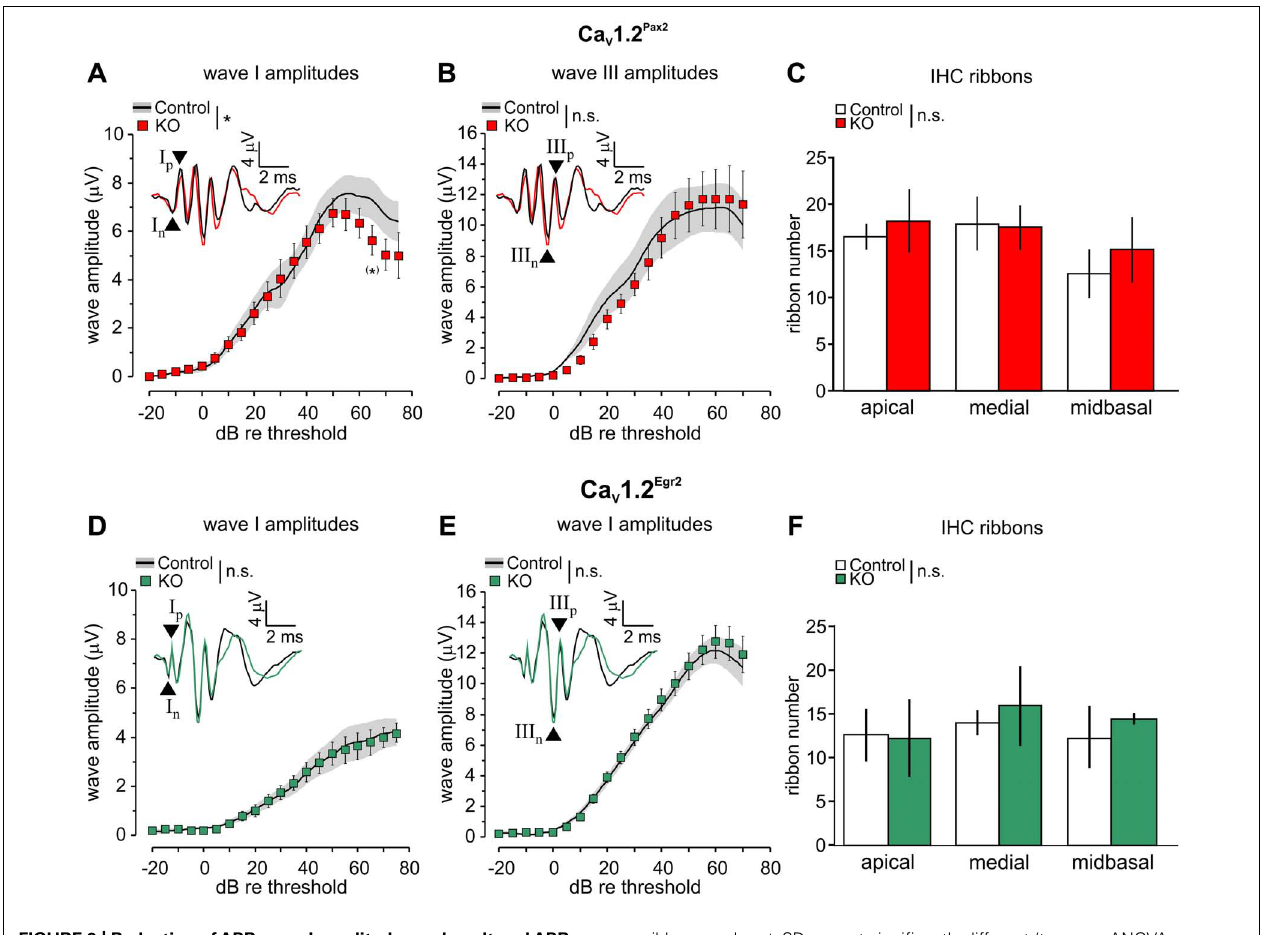
FIGURE 3 | Reduction ofABR wave I amplitudes and unalteredABR wave III amplitudes in Ca V 1.2 Pax2 KO mice. (A) Mean ± SEM click- evoked ABR wave I amplitude growth function for Ca V 1.2 Pax2 control (control, black line, and gray area) and Ca V 1.2 Pax2 KO mice (KO, red squares). ABR wave I amplitudes were significantly different (two-way ANOVA, p = 0.048) between KO ( n = 5–9 ears, 3–6 mice) and controls ( n = 3–6 ears, 3–6 mice), particularly at 65 dB above threshold ( post hoc one-sided Student’s t -test: p = 0.049, no Bonferroni–Holm’s adjustment for multiple testing).The black and red waveforms in the inset depict representative ABR traces measured from one individual ear of a Ca V 1.2 Pax2 control and a KO mouse, respectively, evoked at the level of 65 dB above the hearing threshold.The leading negative (n) and following positive (p) peak corresponded to wave I are indicated by an upward and a downward pointing arrow head associated with symbols “I n ” and “I p ” respectively. (B) Mean ± SEM click-evoked ABR wave III amplitude growth function for controls and Ca V 1.2 Pax2 KO mice. ABR wave III amplitudes were not significantly different (two-way ANOVA, p = 0.639) between KO ( n = 2–5 ears, 2–4 mice) and controls ( n = 3 ears, 2 mice).The leading negative (n) and following positive (p) peak corresponded to wave III are indicated by arrow heads and marked “III n ” and “III p ” respectively. (C) Mean synaptic